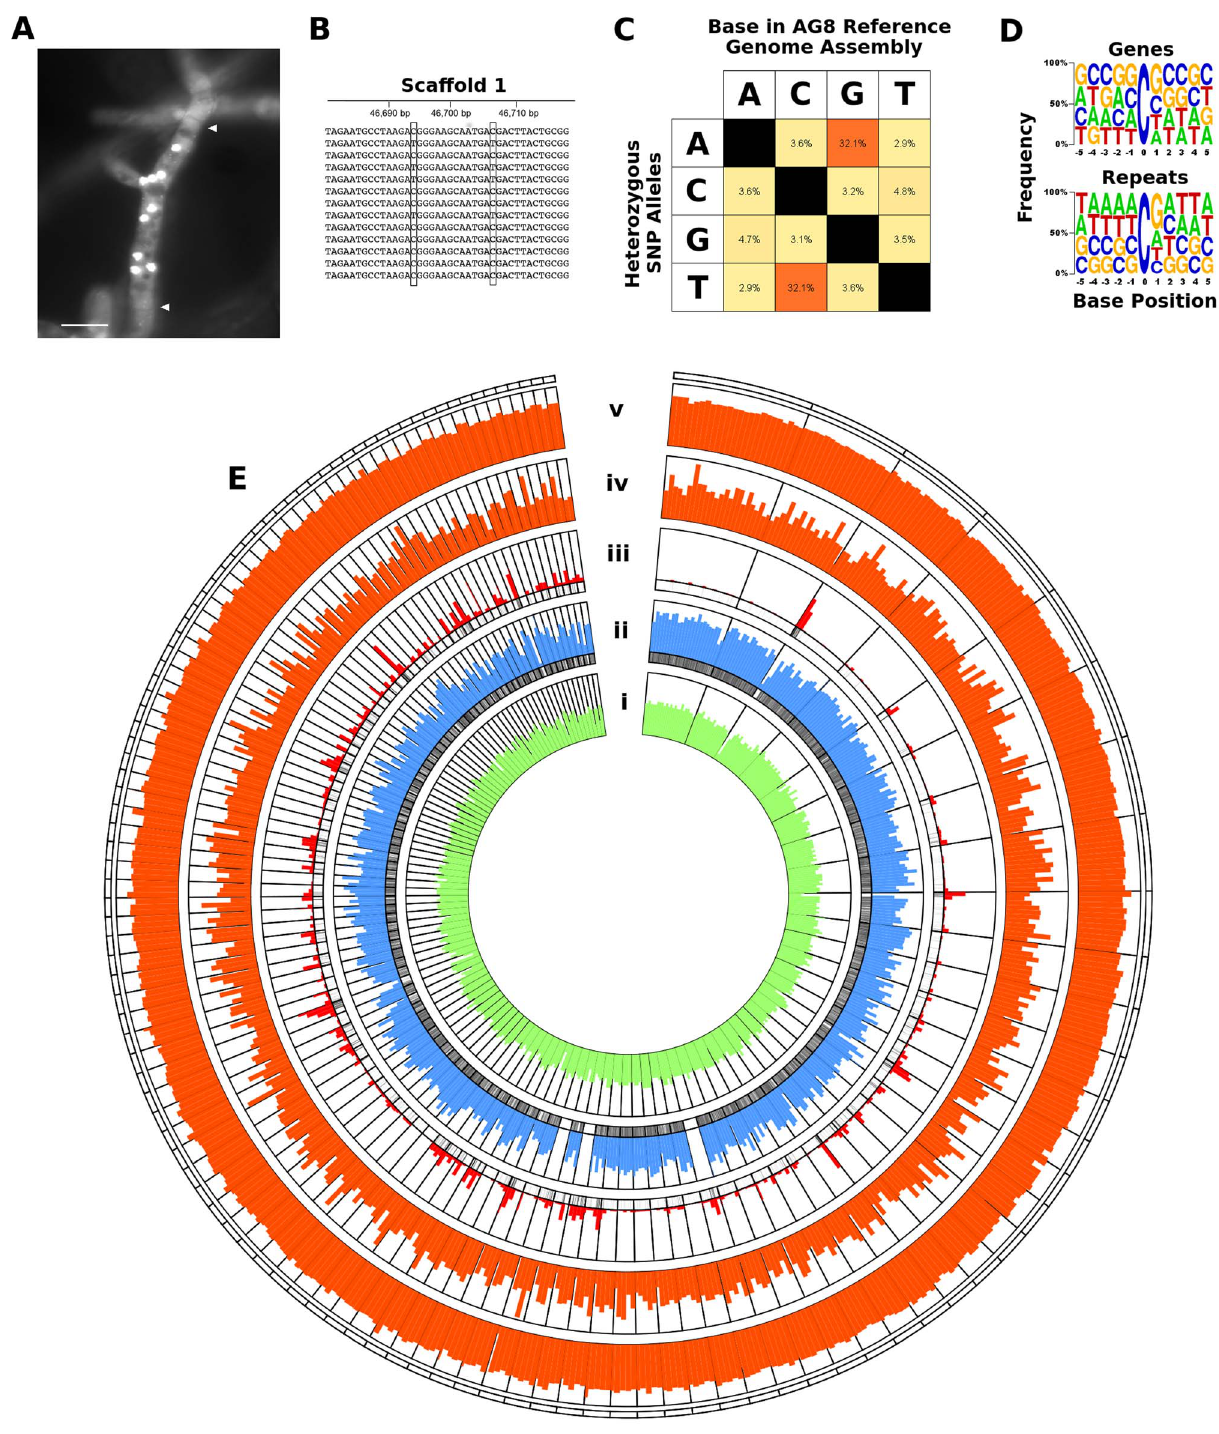
Figure 2. RIP-like mutation was observed across repetitive and gene-encoding regions of the R.solani AG8 assembly. A) Fluorescence micrograph of Rhizoctonia solani AG8 hyphae (stained with SYBR green) displaying multiple nuclei within a single cell. Nuclei appear as brightly fluorescent structures. Hyphal septa are indicated with arrows and the scale bar is equivalent to 20 m m. Prior to genome analysis, sequence variation between nuclei was unknown. B) Close-up view of the genomic region corresponding to actin gene RSAG8_00181 , with short genomic sequence reads used in its assembly. This is representative of most genomic regions, in which constituent short reads exhibit two dominant haplotypes differentiated by low frequency SNP mutation. C) Percentage frequency matrix of SNP mutation type at heterozygous sites in the AG8 assembly. The majority were transition mutations between cytosine and thymine (reverse complement adenine and guanine). D) Frequency logos of the base composition of the sequences flanking heterozygous C « T transitions in gene and repeat sequences, exhibiting a moderate bias for a 3 9 guanine (i.e. CpG) in both. E) Distribution of genes, repeats and cytosine hypermutations across AG8 nuclear scaffolds of at least 100 kbp in length (scaffolds 1-76 and 78-117). All plot data in concentric rings are calculated within sequential 100 kbp windows, in order from the centre outwards: (i) G:C content